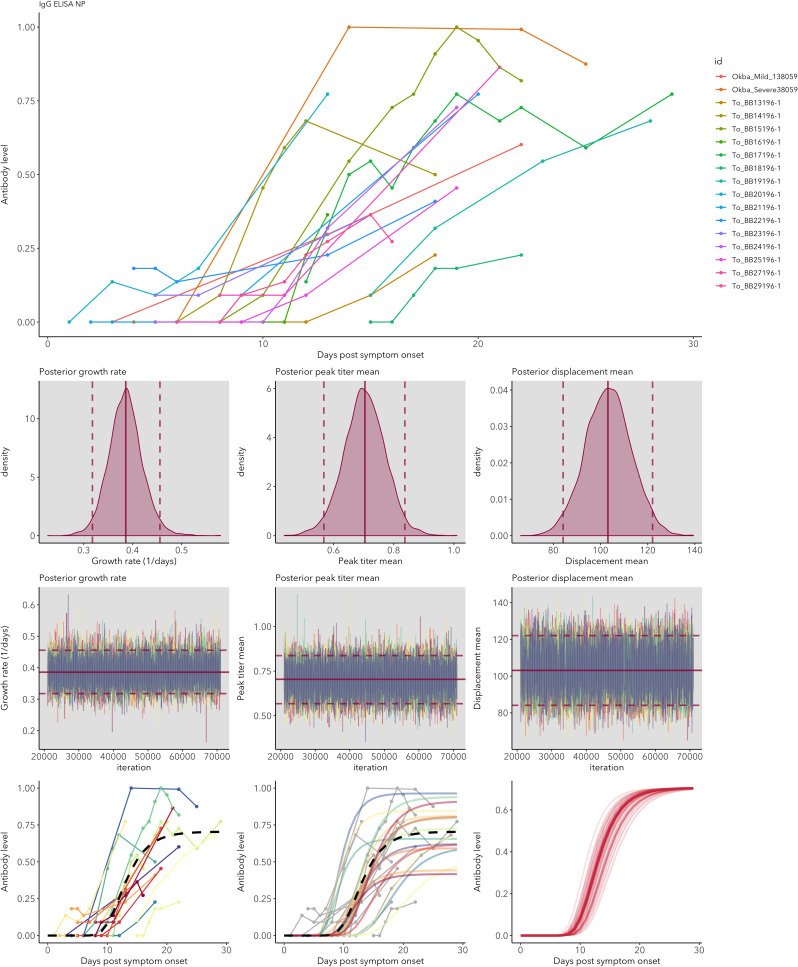
IgG ELISA-NP fitted antibody kinetics.